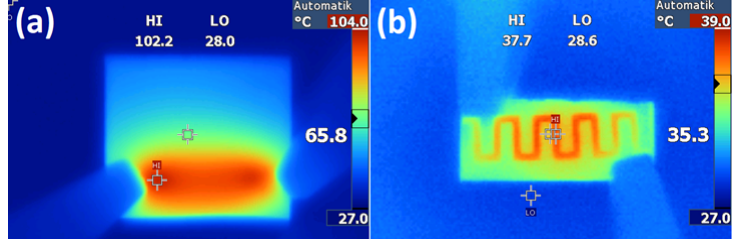
Figure 10. The temperature distribution of bottom glass substrate: (a) without nanostructures deposited film; and (b) with the CuO nanostructures deposited film and with gold contacts on